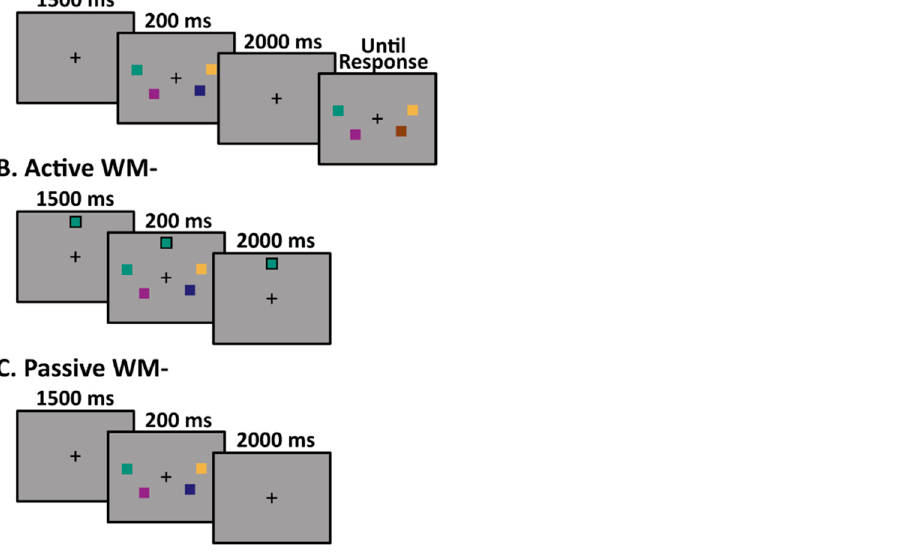
Figure 2. Trial sequence for the three tasks: ( A ) Active WM+, ( B ) Active WM-, and ( C ) Passive WM-.